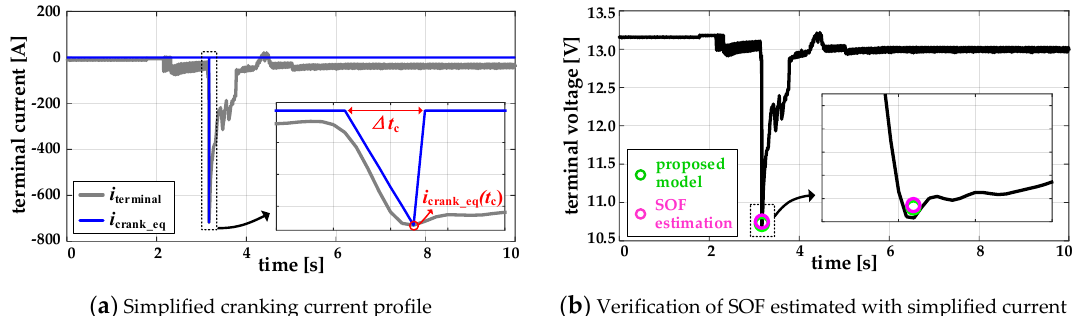
Figure 10. Equalization of cranking current profile.